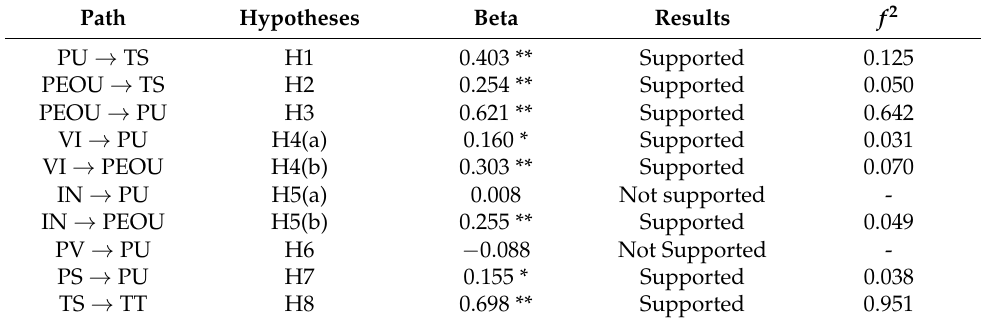
Table 6. Results of the Hypotheses